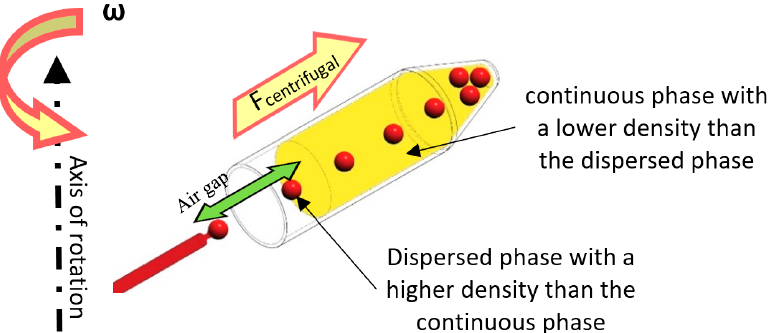
Figure 6. Schematic view of the dispenser nozzle method for droplet and particle generation. Droplets are produced at the tip of the nozzle and enter a tube containing a continuous phase.